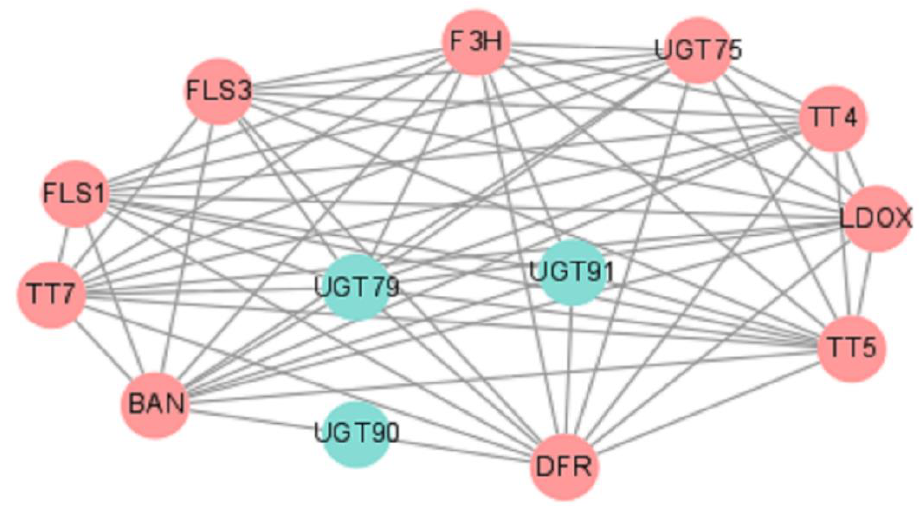
Figure 8. Protein–protein interaction network of Eu UGTs with A. thaliana as reference predicted by using String web server. The blue circles represent the input Eu UGTs; the red circles show the protein partners. BAN, NAD(P)-binding Rossmann-fold superfamily protein; DFR, dihydroflavonol reductase; FLS1, flavonol synthase/flavanone 3-hydroxylase; FLS3, flavonol synthase; TT4, flavonol synthase; TT5, chalcone-flavanone isomerase; TT7, cytochrome P450; F3H, naringenin,2-oxoglutarate 3-dioxygenase; LDOX, leucoanthocyanidin dioxygenase; and UGT75, anthocyanidin 5- O -glucosyltransferase.